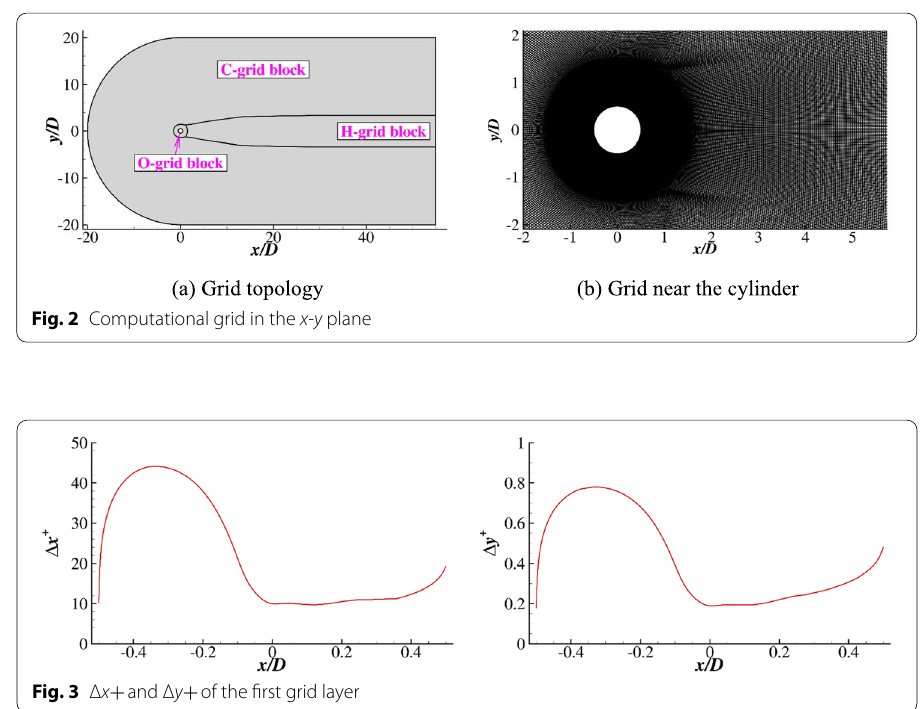
and Δ y of the first grid + +